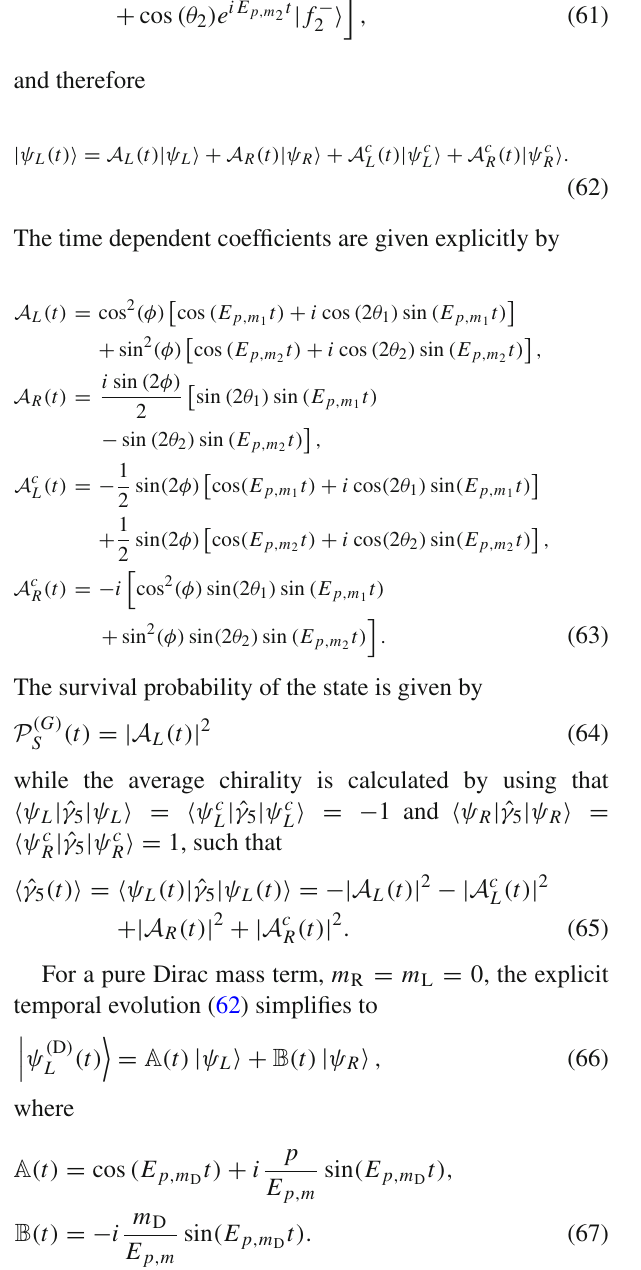
| ψ ( D ) ( t ) (cid:2) = (cid:5) ψ ( M ) 5 L